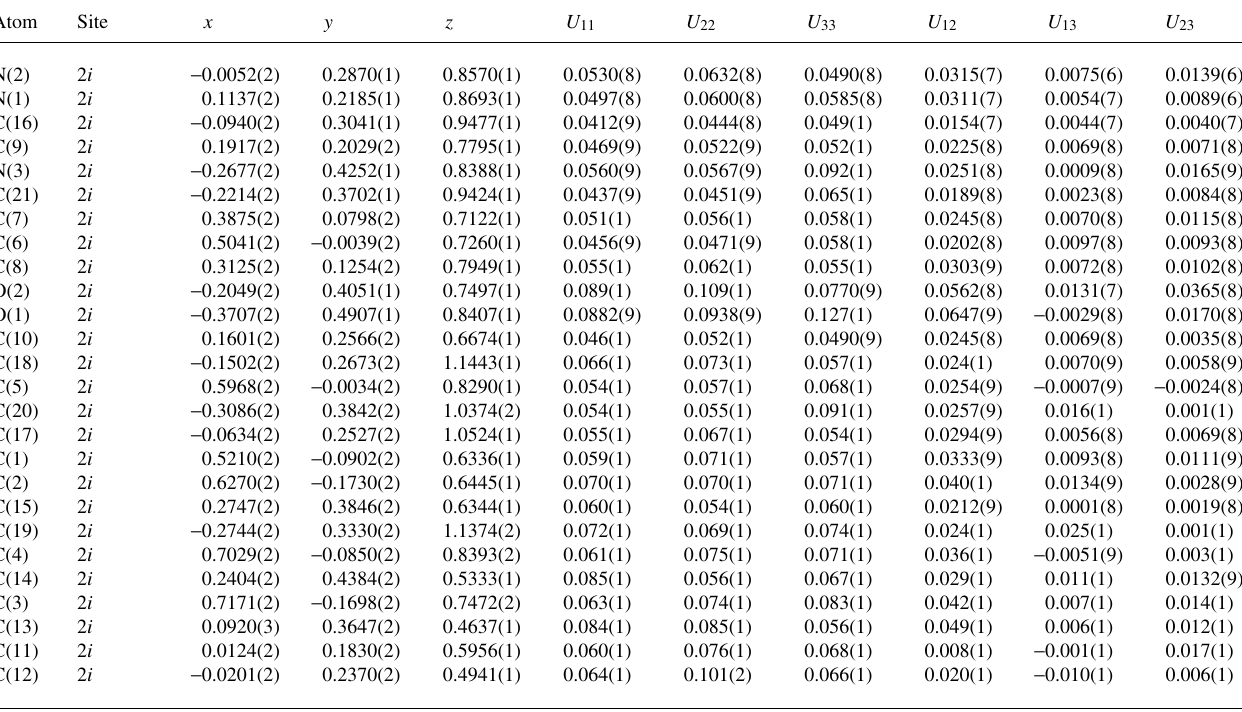
Table 3. Atomic coordinates and displacement parameters (in Å 2 )